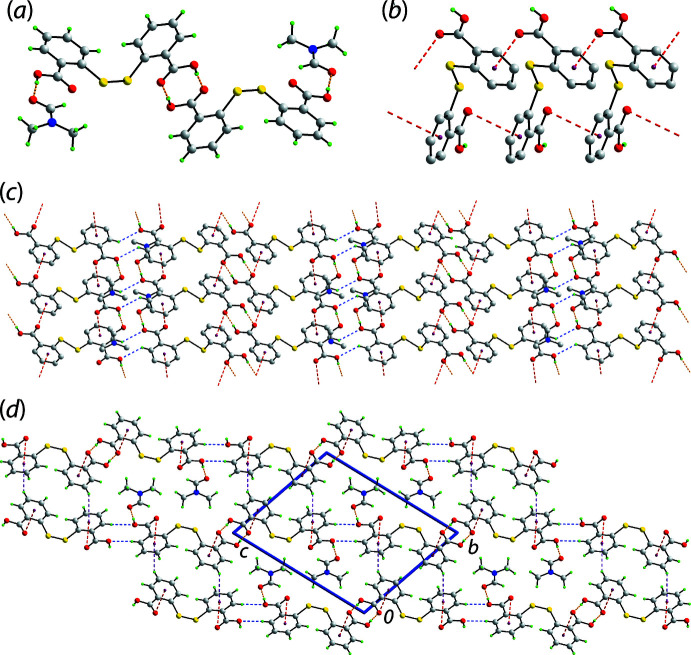
Mol­ecular packing in the crystal of (I): (a) the four-mol­ecule aggregate sustained by DTBA-O—H⋯O(DMF) and DTBA-O—H⋯O(DTBA) hydrogen bonding shown as orange dashed lines, (b) the supra­molecular chain sustained by carbonyl-O⋯π(benzene) inter­actions shown as red dashed lines, (c) the supra­molecular layer with benzene-C—H⋯O(DTBA) inter­actions shown as blue dashed lines and (d) a view of the unit-cell contents down the a axis with benzene-C—H⋯π(benzene) inter­actions shown as purple dashed lines. In (b) and (c) the non-participating H atoms have been omitted to aid clarity.